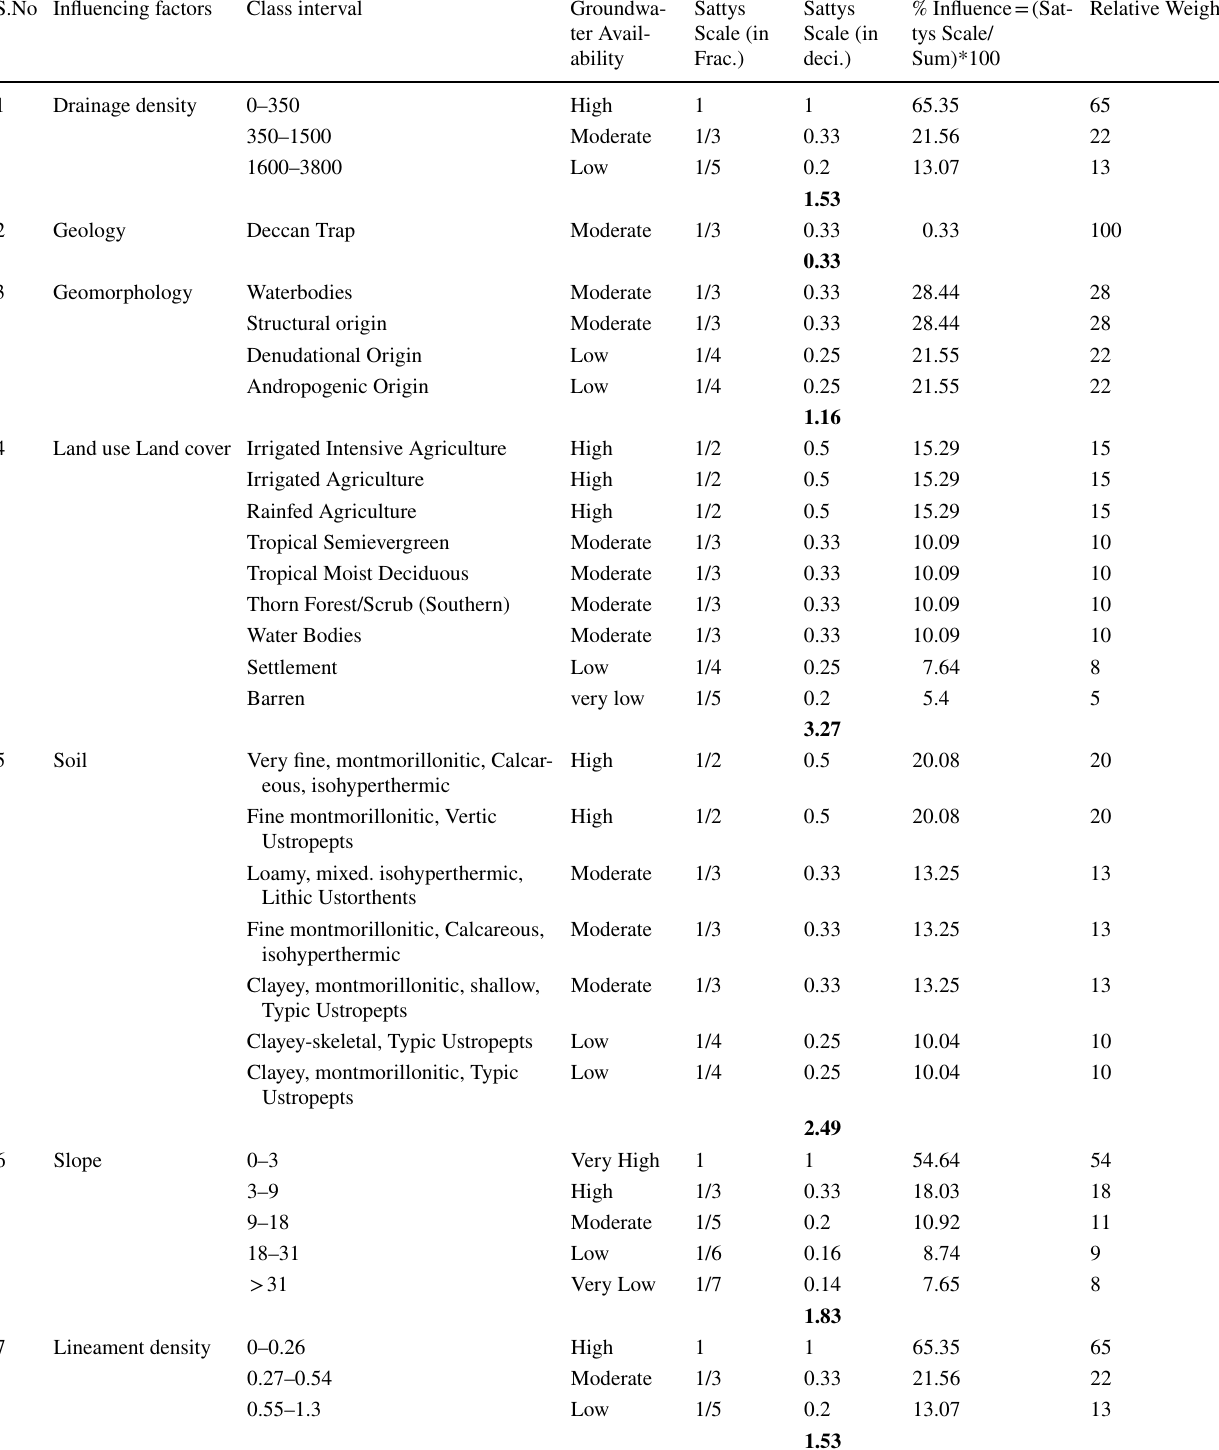
Table 3 Assigned weight according to Satty’s analytical hierarchical process S.No Influencing